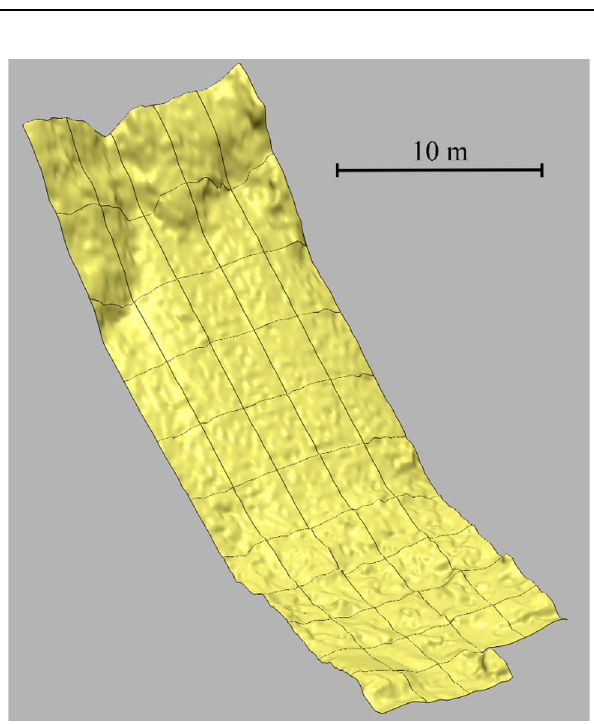
Fig. 12 NURBS surface fitted into optimized mesh